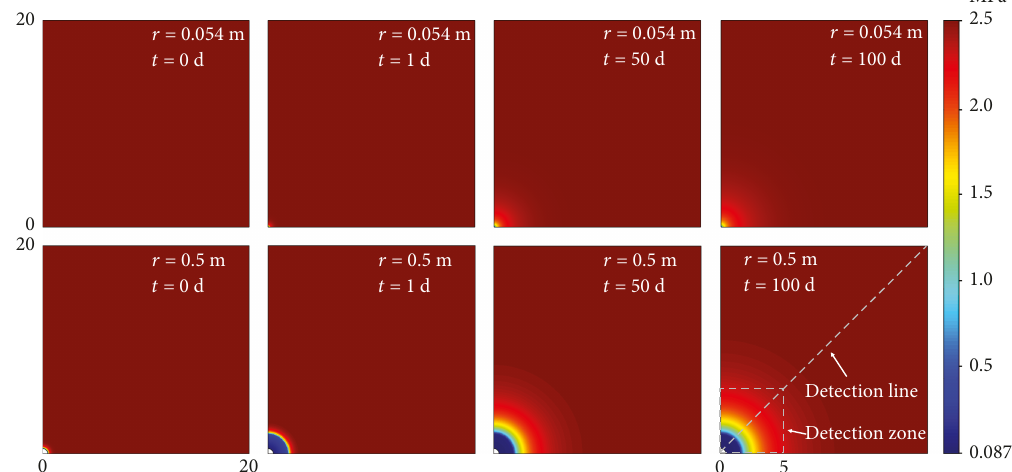
Figure 9: Case A and case B: gas pressure distributions around a